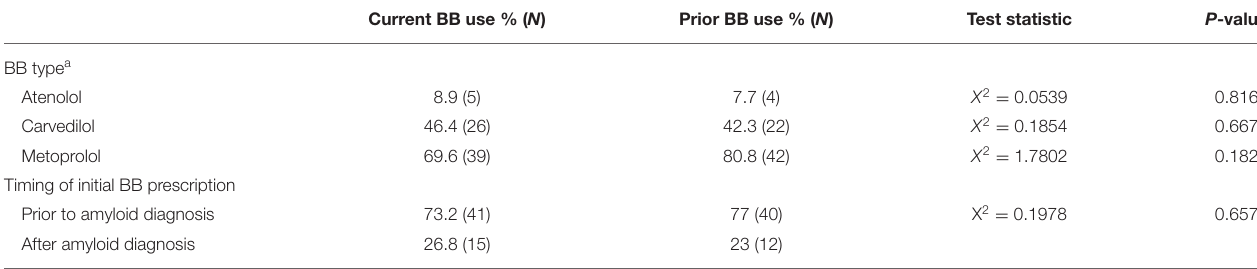
TABLE 2 | Beta-blocker (BB) prescription type and timing in relationship to amyloidosis